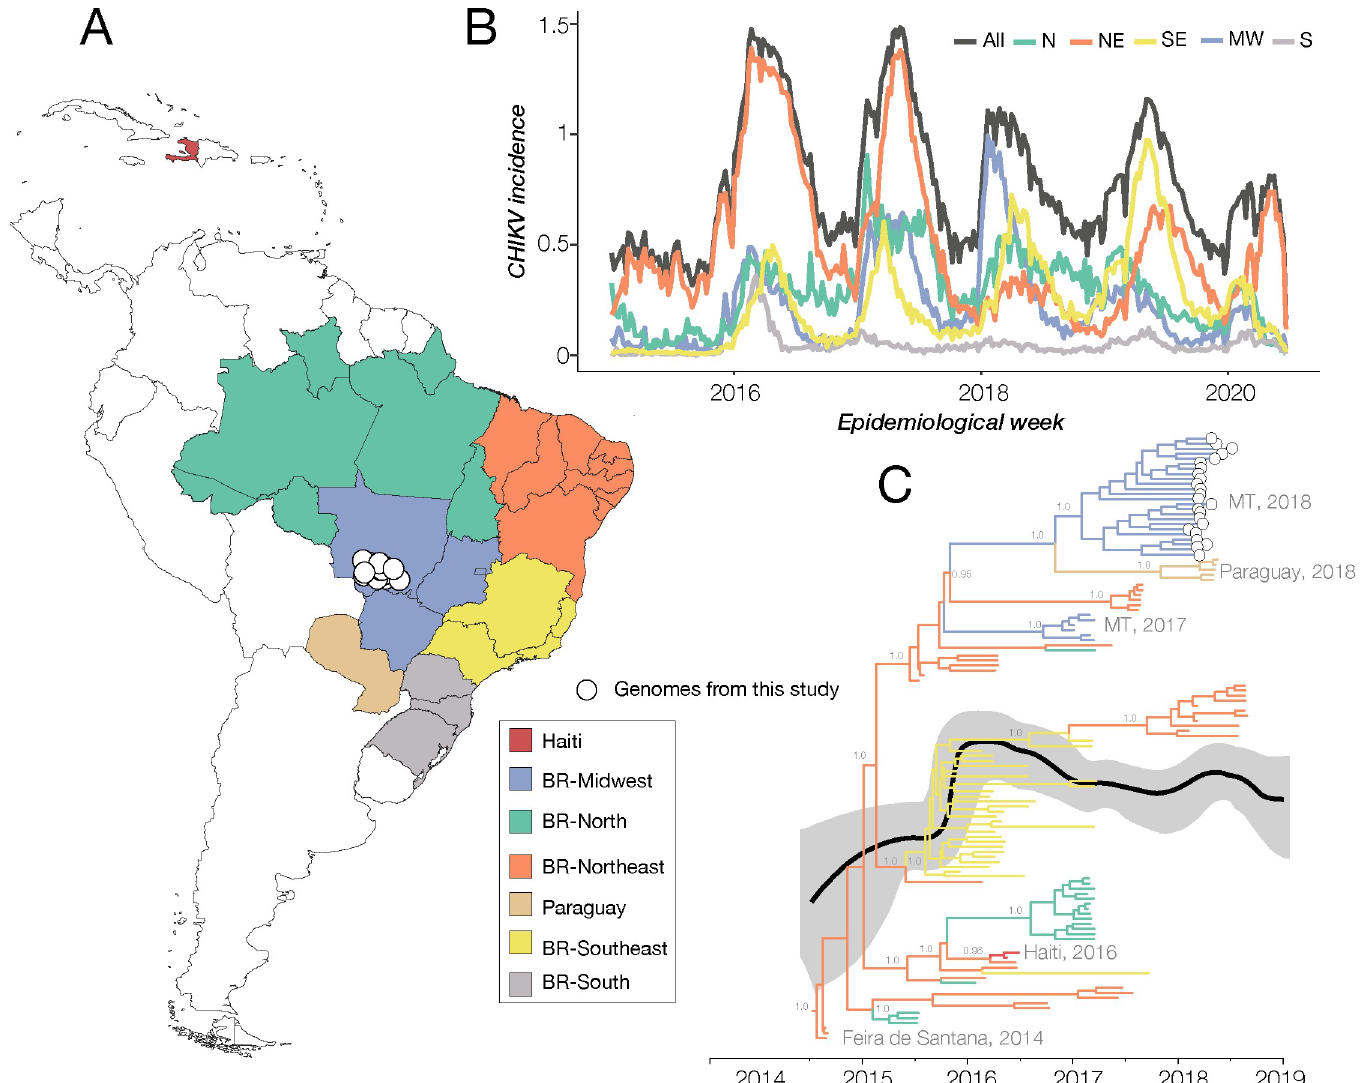
Fig 1. CHIKV transmission dynamics in Brazil (2014–2019). (A) Map of Brazil and Americas showing sampling location of the CHIKV genomes from this study (white circles). (B) Weekly notified chikungunya cases normalized per 100K individuals per Brazilian region in 2015–2020 (until EW06). Incidence (cases per 100K population) is presented in log10 for visual purposes. Epidemic curves are coloured according to geographical macro region: SE = Southeast, NE = Northeast, MW = Midwest, N = North, S = South. (C) Time-scaled phylogeographic tree of 120 complete and near-complete CHIKV genome sequences from the ECSA genotype sampled in Brazil and Americas. Colours represent different sampling locations according to the legend on the left of the tree. Tip circles (white) represent the genome sequences generated in this study. Skyline plot (black and gray lines) is superimposed. Relative genetic diversity is represented here as a surrogate for the product of effective population size and generation time. The solid black line represents the mean relative genetic diversity and the light gray area around the line represents the 95% HPD interval of the estimates.